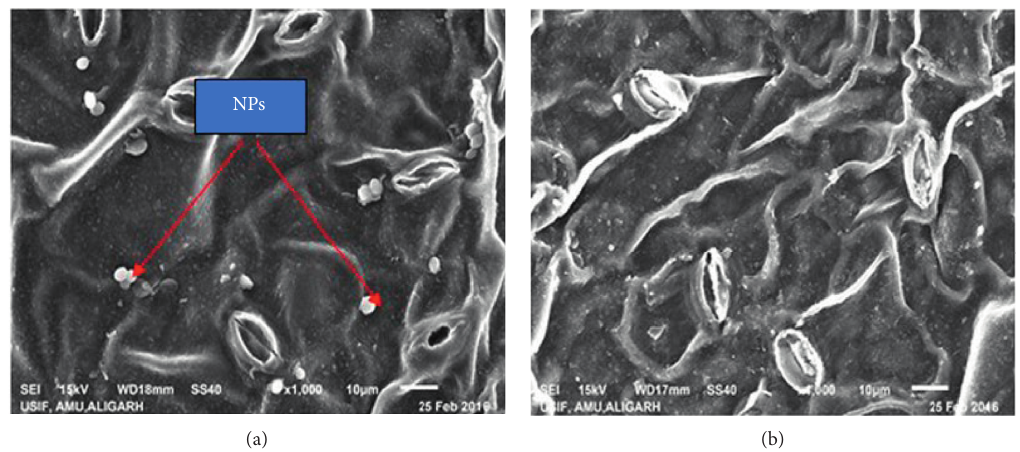
Figure 4: Scanning electron microscope (SEM) image of treated with CuO NPs (a) and control (b).